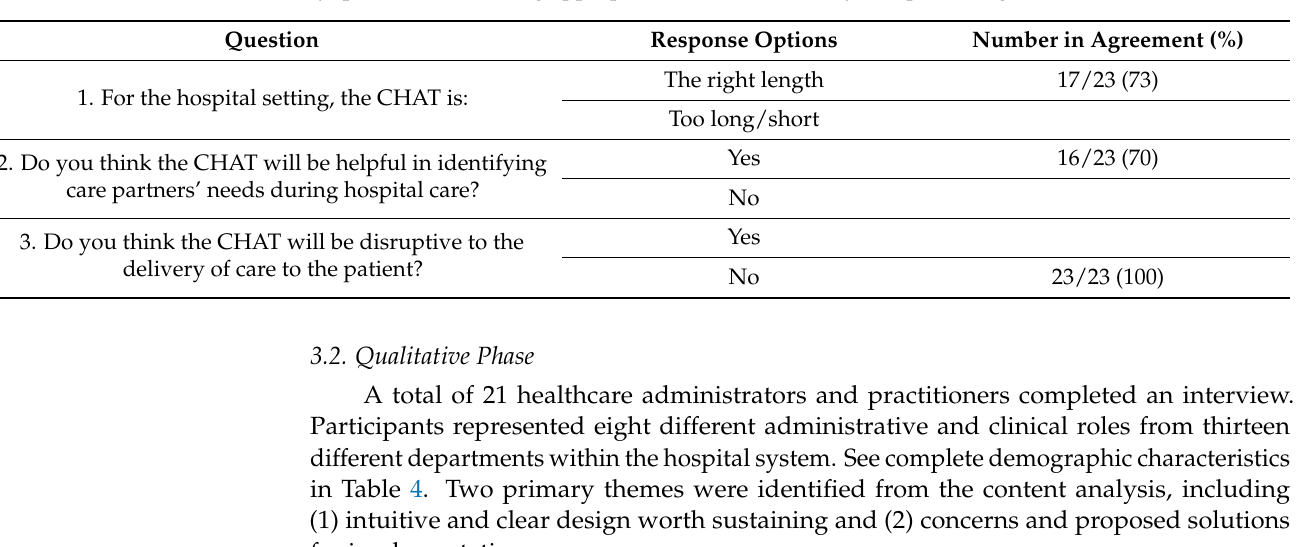
Table 3. Survey questions addressing appropriateness and feasibility and percent